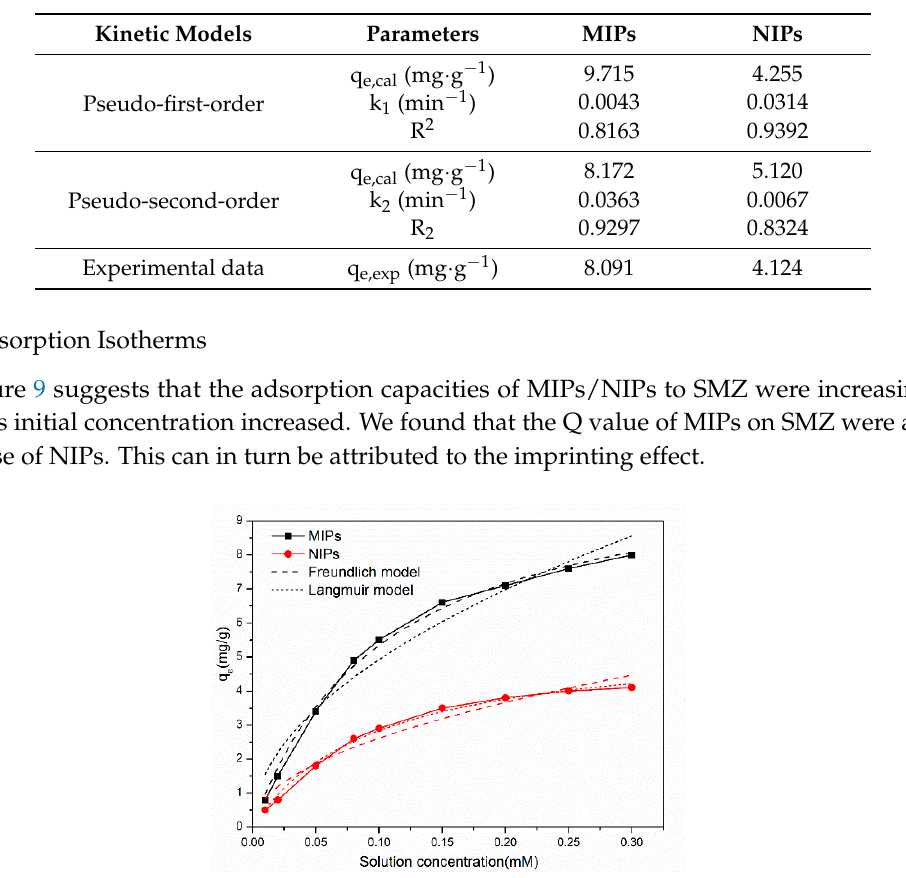
Table 2. Adsorption kinetics fitting parameters of MIPs and NIPs towards SMZ.